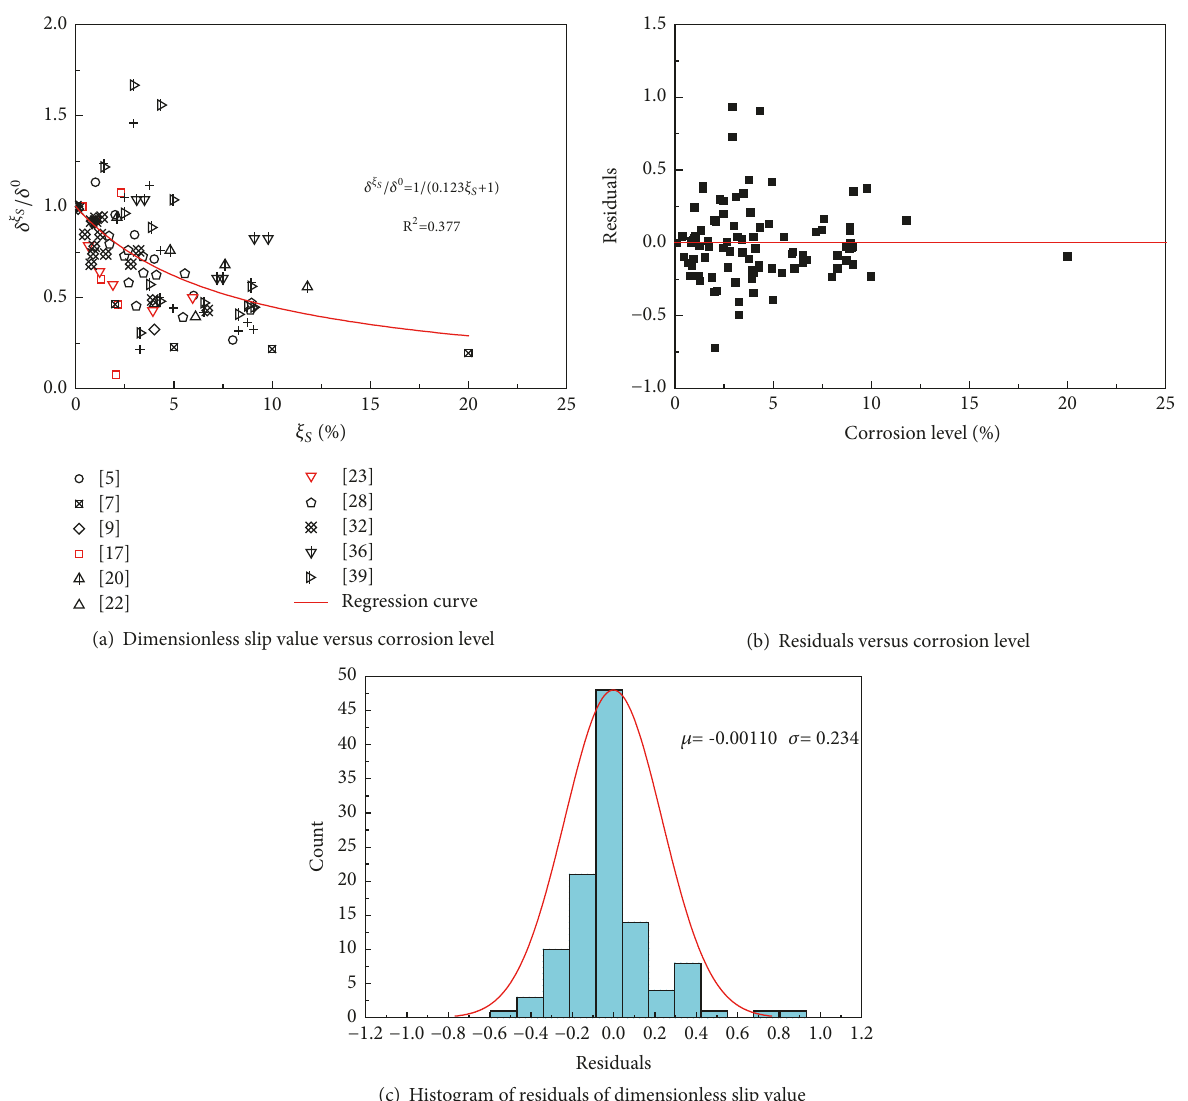
Figure 4: Dimensionless slip value corresponding to bond strength of pull-out specimens with deformed rebar (no stirrups): (a) dimensionless slip value versus corrosion level; (b) residuals versus corrosion level; (c) histogram of residuals of dimensionless slip